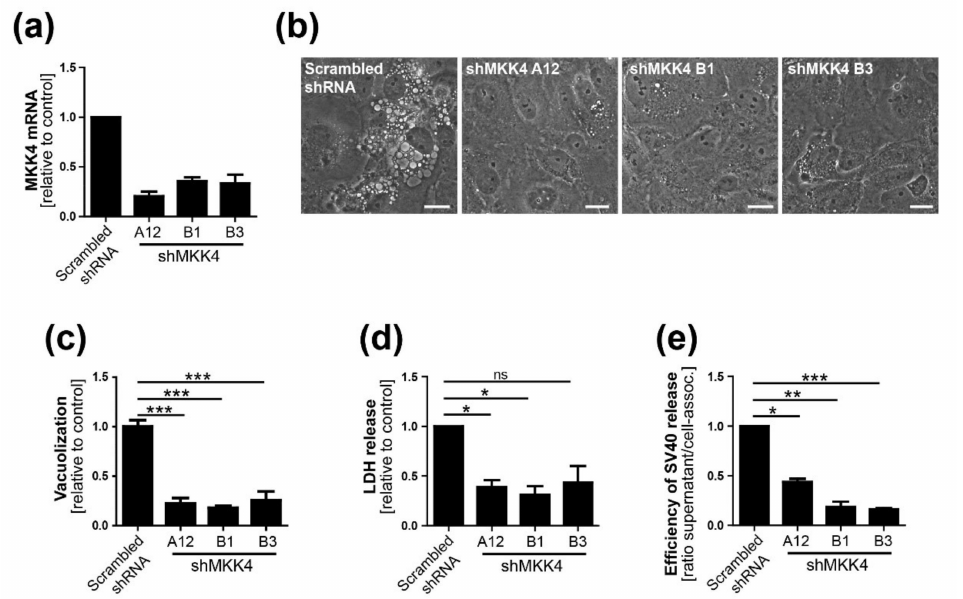
Figure 7. MKK4 is required for e ffi cient SV40-induced vacuolization, cell lysis, and virus release. ( a ) qPCR analysis of MKK4 mRNA expression levels in CV-1 cells stably expressing three di ff erent shRNAs targeting MKK4 (A12, B1, and B3): levels of mRNA were normalized to mRNA in control cells expressing scrambled shRNA; ( b ) Images of SV40-infected control and MKK4 knockdown cells: CV-1 cells stably expressing scrambled control shRNA or MKK4 A12, B1, or B3 shRNA were